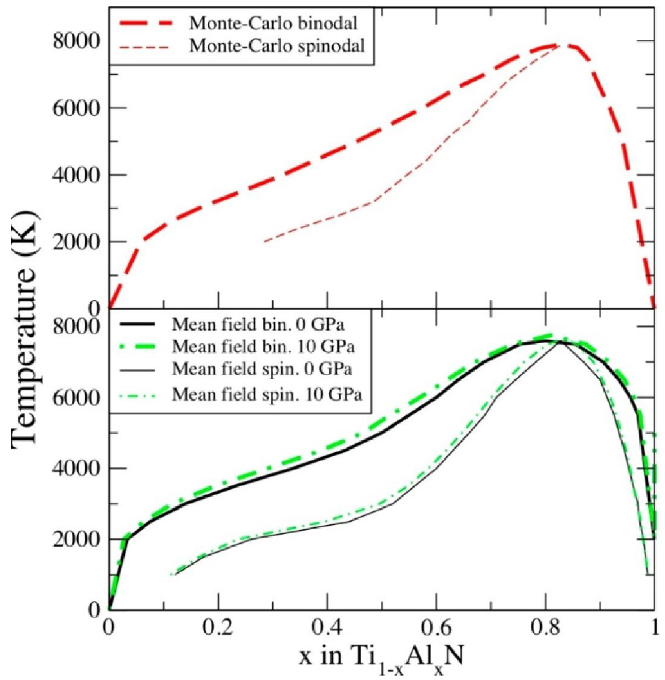
Figure 5. The isostructural phase diagram of cubic Ti Carlo approach [28] ( a ) and with the mean-field approximation [15,28] ( b ). In the latter case we also show the phase diagram calculated at elevated pressure P = 10 GPa [27]. The binodal lines are shown with thick lines while the spinodal lines are shown by thin